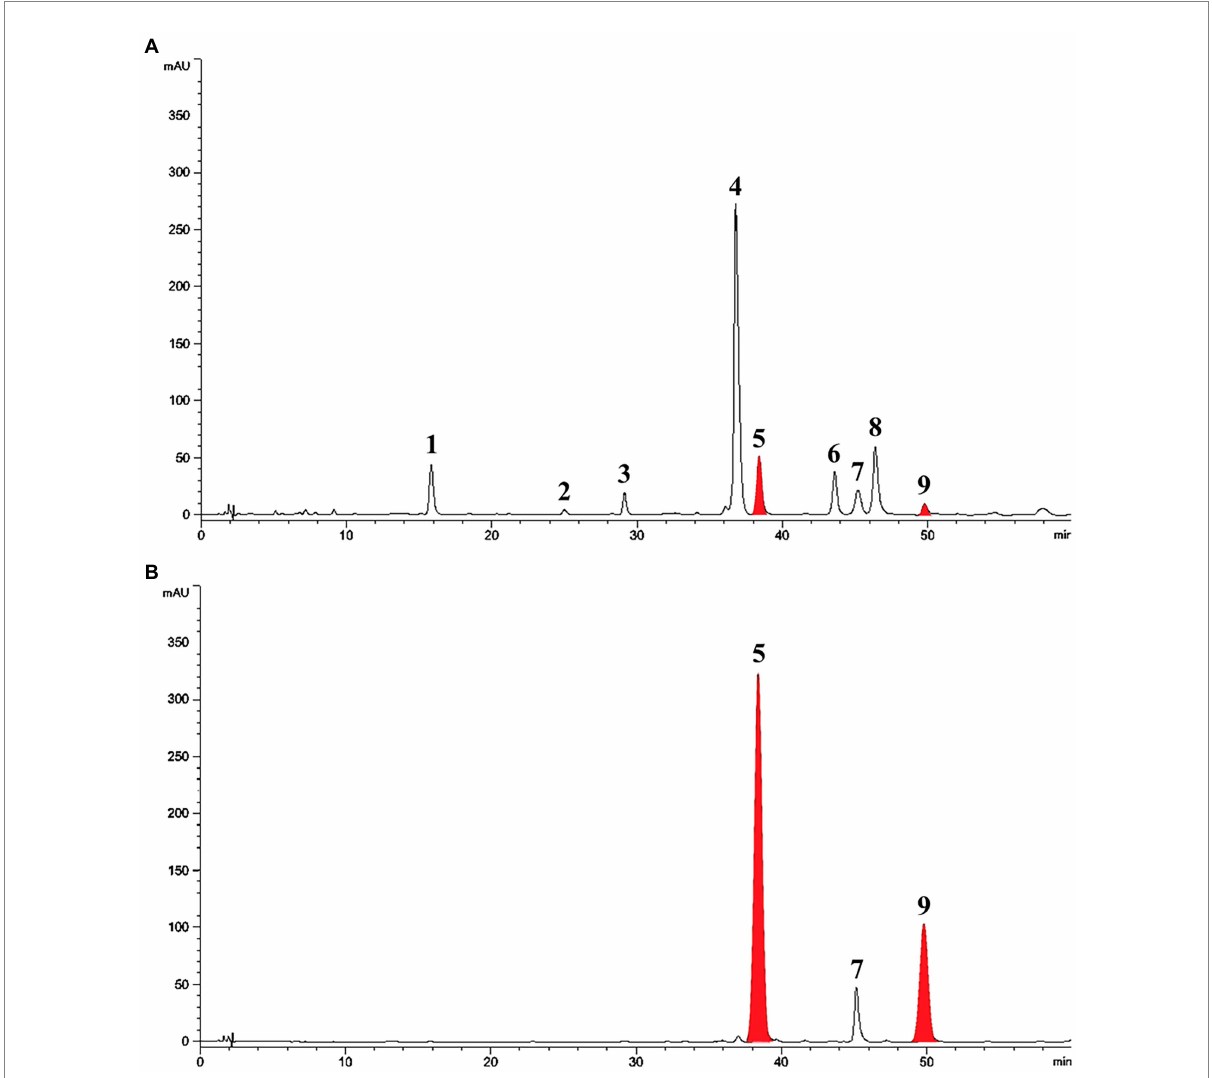
FIGURE 2 HPLC chromatographic patterns of soybean root extracts at 254 nm. Peak 1, daidzin; peak 2, genistin; peak 3, coumestrin; peak 4, malonyldaidzin; peak 5, daidzein; peak 6, malonylgenistin; peak 7, genistein; peak 8, malonylcoumestrin; peak 9, coumestrol. (A) Control soybean roots. (B) SA treated soybean